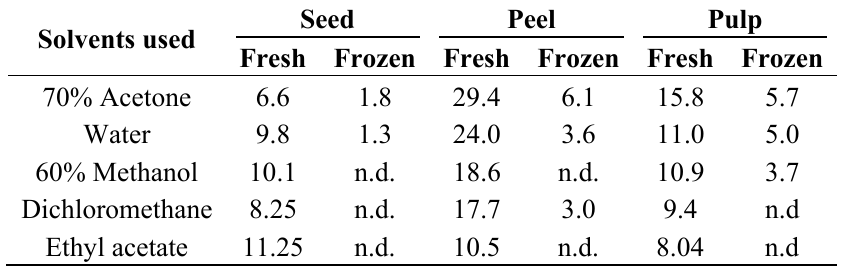
Table 6. DMPD antiradical activity (TEAC μ mol/g) of various parts of fresh and frozen fruit [46]. Solvents